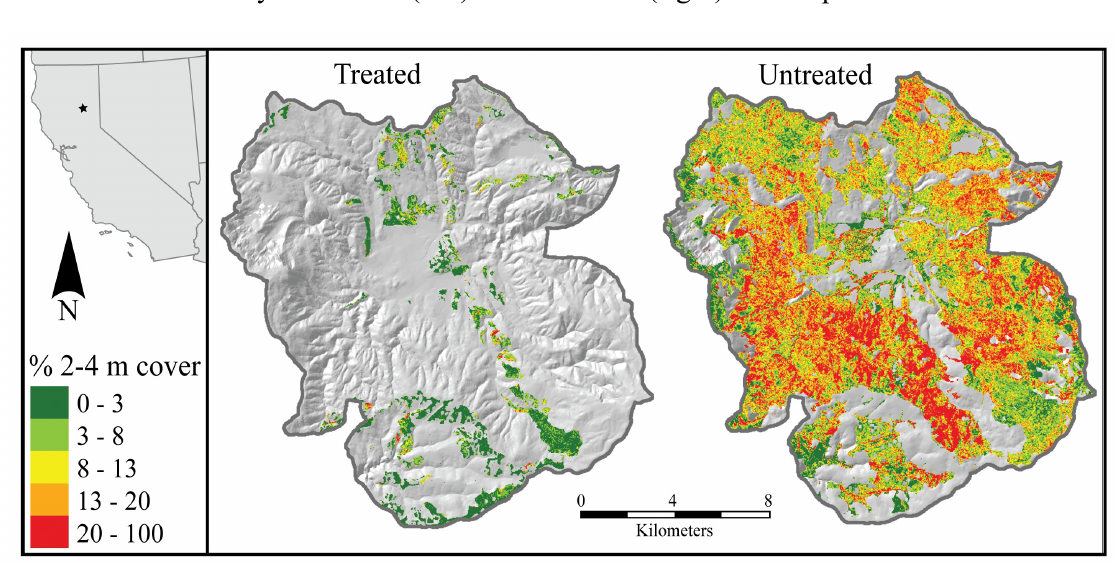
Figure 4. Meadow Valley study area, showing areas with fuel reduction and those with no treatment after 1999; green to red color scale indicates the relative percentage of 2–4 m cover across the analyzed treated (left) and untreated (right)